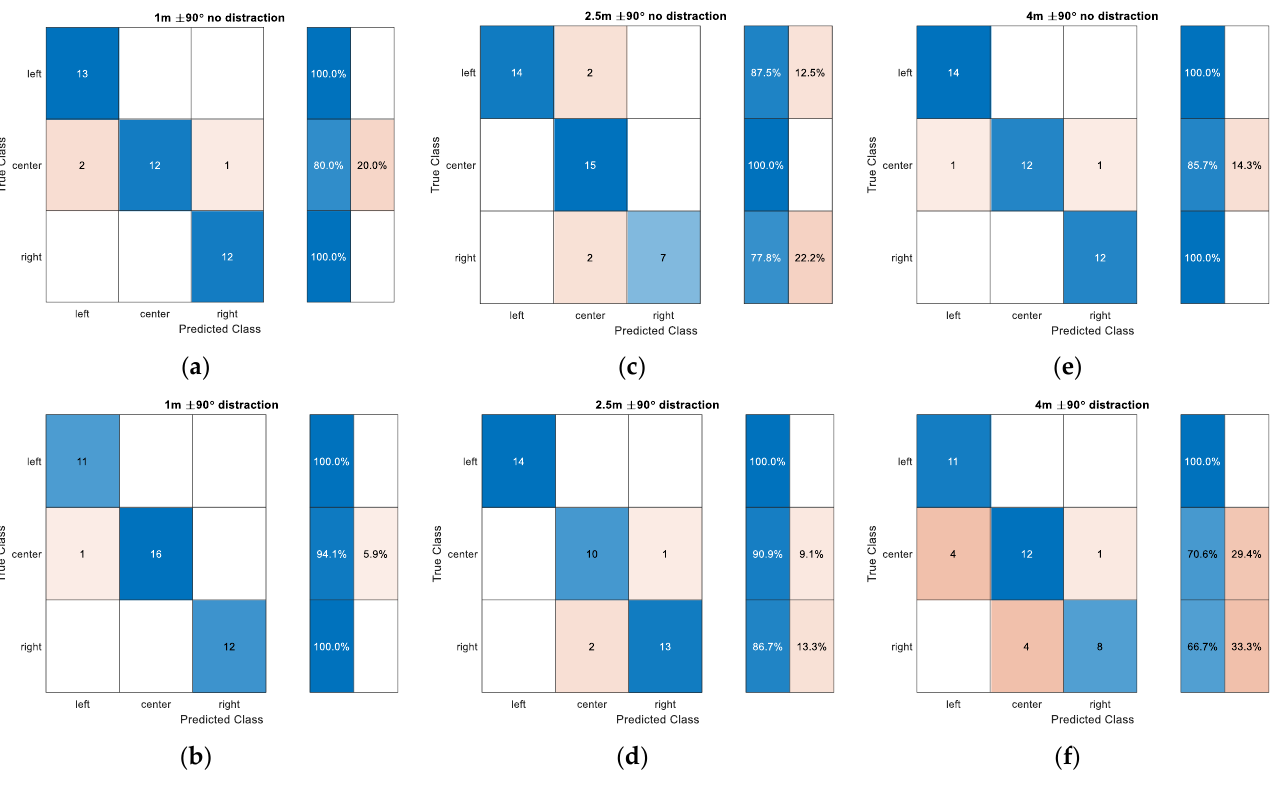
Figure 21. Confusion matrix for wide angle situations : ( a ) 1 m and ±90° without distraction; ( b ) 1 m and ±90° with distraction; ( c ) 2.5 m and ±90° without distraction; ( d ) 2.5 m and ±90° with distraction; ( e ) 4 m and ±90° without distraction; ( f ) 4 m and ±90° with distraction.